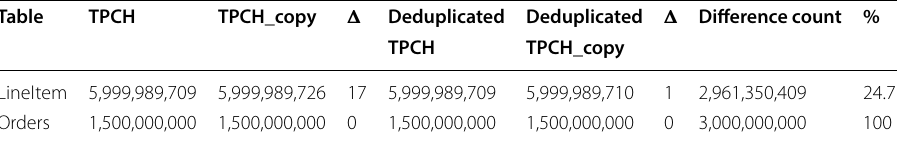
Table 10 Row validation statistics—“LineItem" and “Orders" tables Table